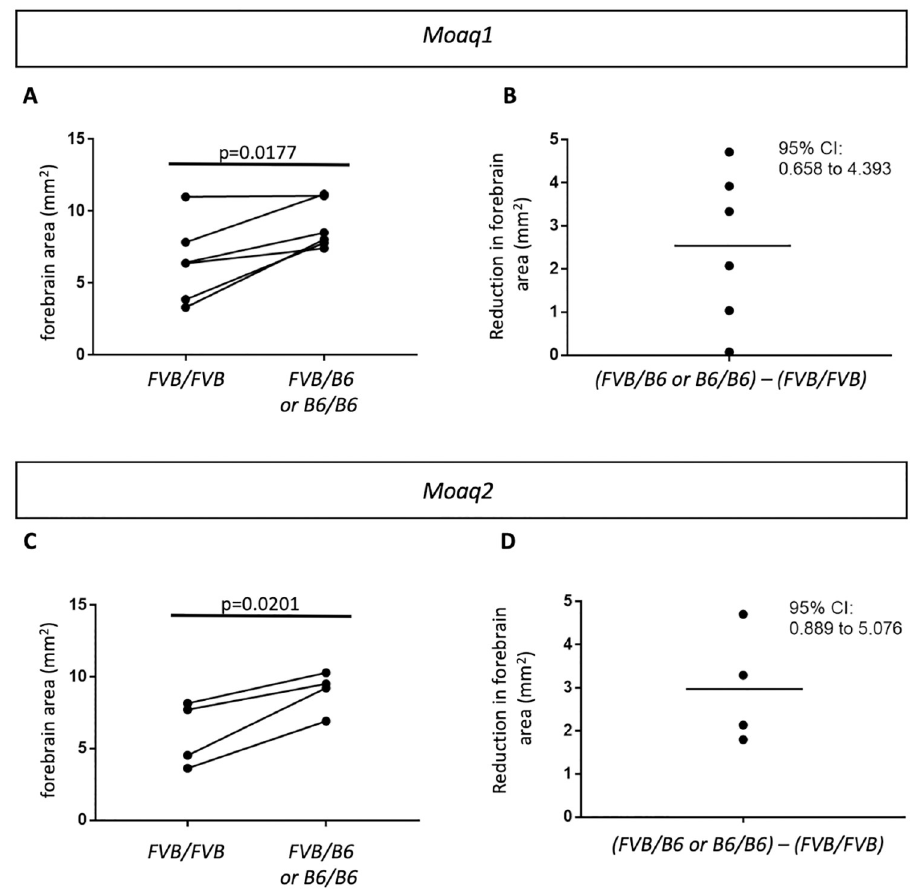
Fig 3. Congenic line validation of Moaq1 and Moaq2 . (A) Forebrain size from Ttc21b aln/aln -Moaq1 FVB/FVB (FVB/ FVB) and Ttc21b aln/aln -Moaq1 FVB/B6 or B6/B6 (FVB/B6 or B6/B6). (B) The amount of forebrain reduction in (FVB/B6 or B6/B6)–(FVB/FVB) brain sizes shows an average decrease of 2.24mm 2 . (C,D) Parallel analyses for Moaq2 animals are